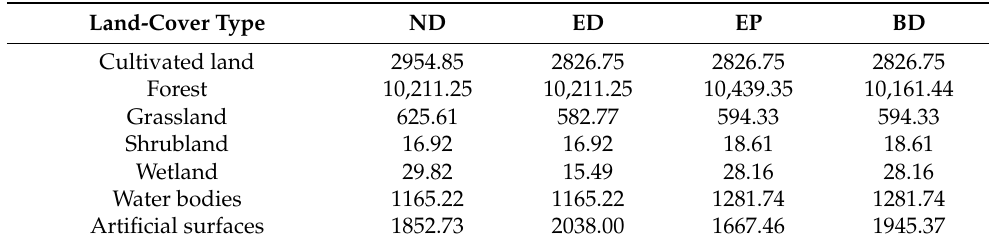
Table 10. Area of each land-cover type in Hangzhou under four scenarios in 2030 (unit: km 2 ). Land-Cover Type ND ED